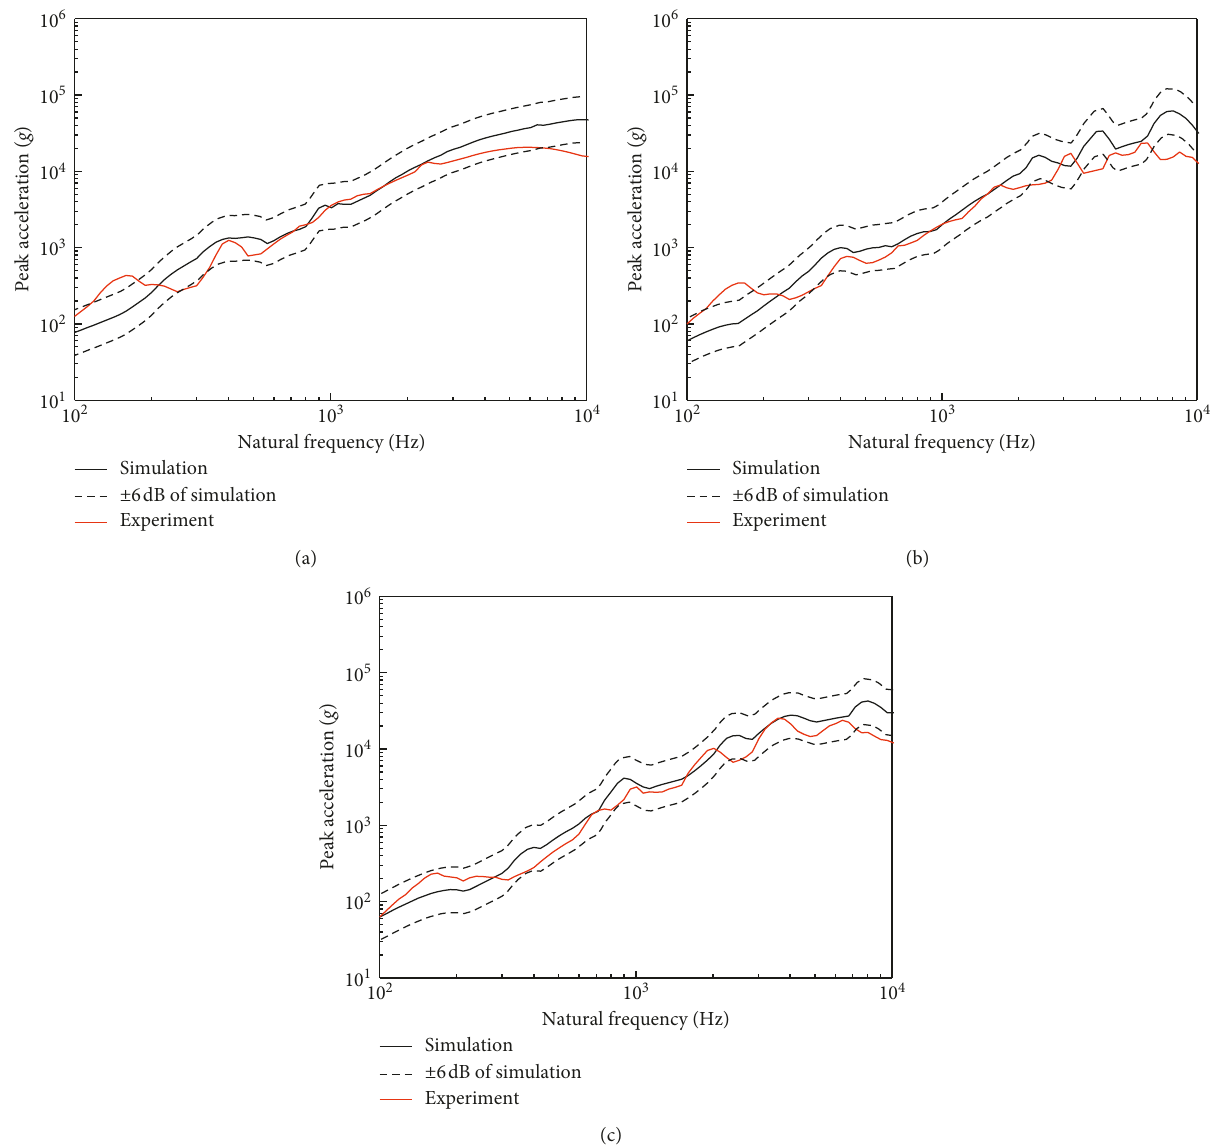
Figure 15: Comparison of SRS levels between simulation and experiment [32]. (a) 5cm. (b) 10cm. (c) 15